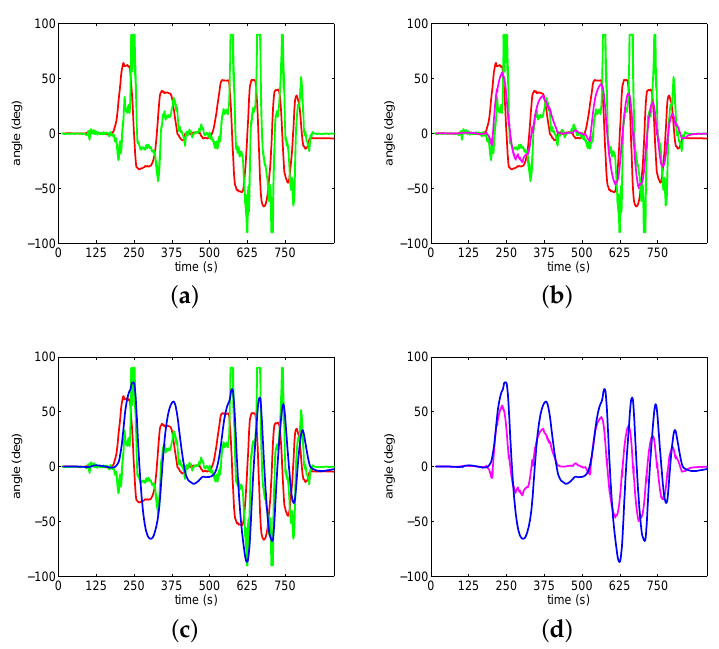
Figure 11. Experiment 4 (Red line is angular output of gyro. Green line is angular output of accelerometer. Carmine line is angular output after compensation. Blue line is angular output after Kalman filter.). ( a ) Angular outputs of gyro/accelerometer; ( b ) Applying the proposed compensation method; ( c ) Applying Kalman filtering method; ( d ) Comparison of two